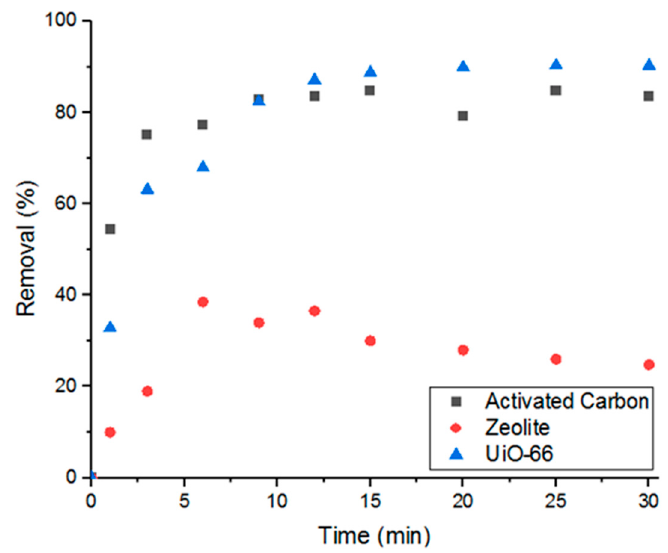
Figure 2. Percent removal of Doxycycline via three di ff erent types of porous materials.